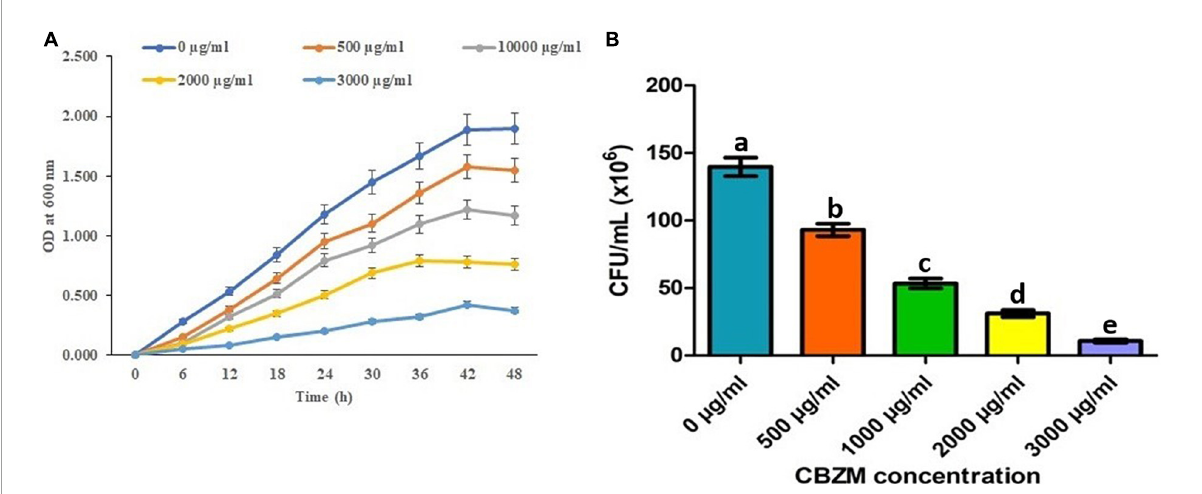
FIGURE2 Effect of different concentrations of CBZM on rhizobacteria ANCB-12 growth (A) and variability in terms of CFU count (B) up to 48 h time duration. The data represent the mean ± SEM ( n = 3) of three replicates. The error bars display the standard error mean (SEM). a–e indicate the statistically significant value. Letters on each bar denote significant variances ( p ≤ 0.05) according to the DMRT